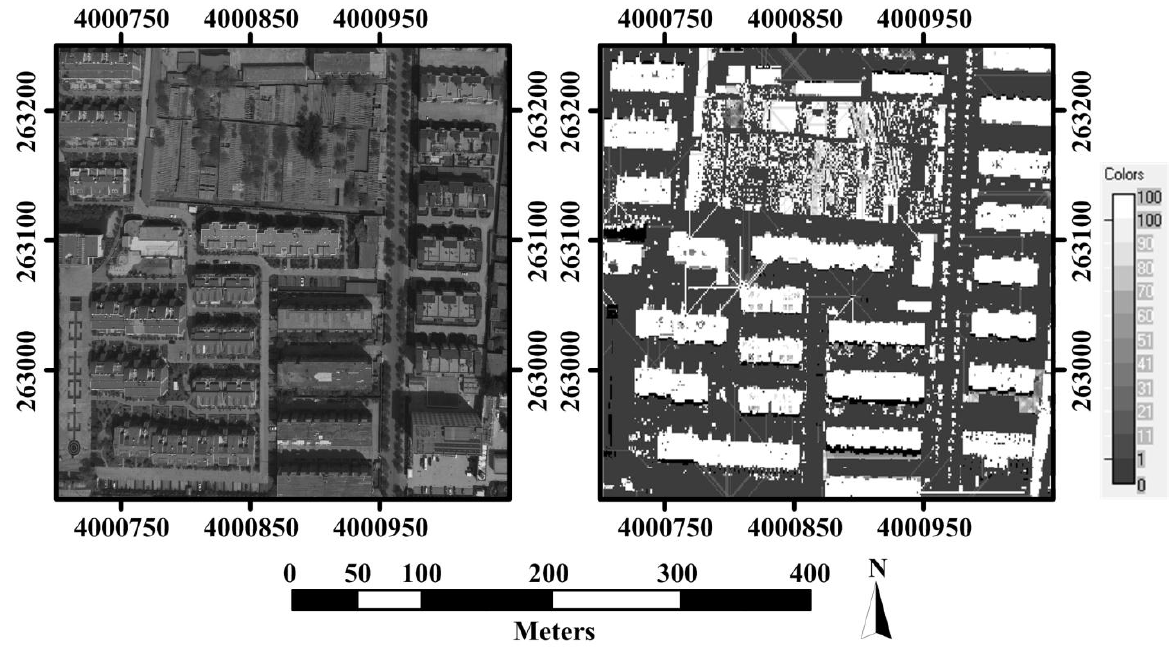
Figure 5. Ground saliency results: ( left ) is the corresponding image of point cloud ( right ); (right) is grayed by (1.0 − γ ) × p